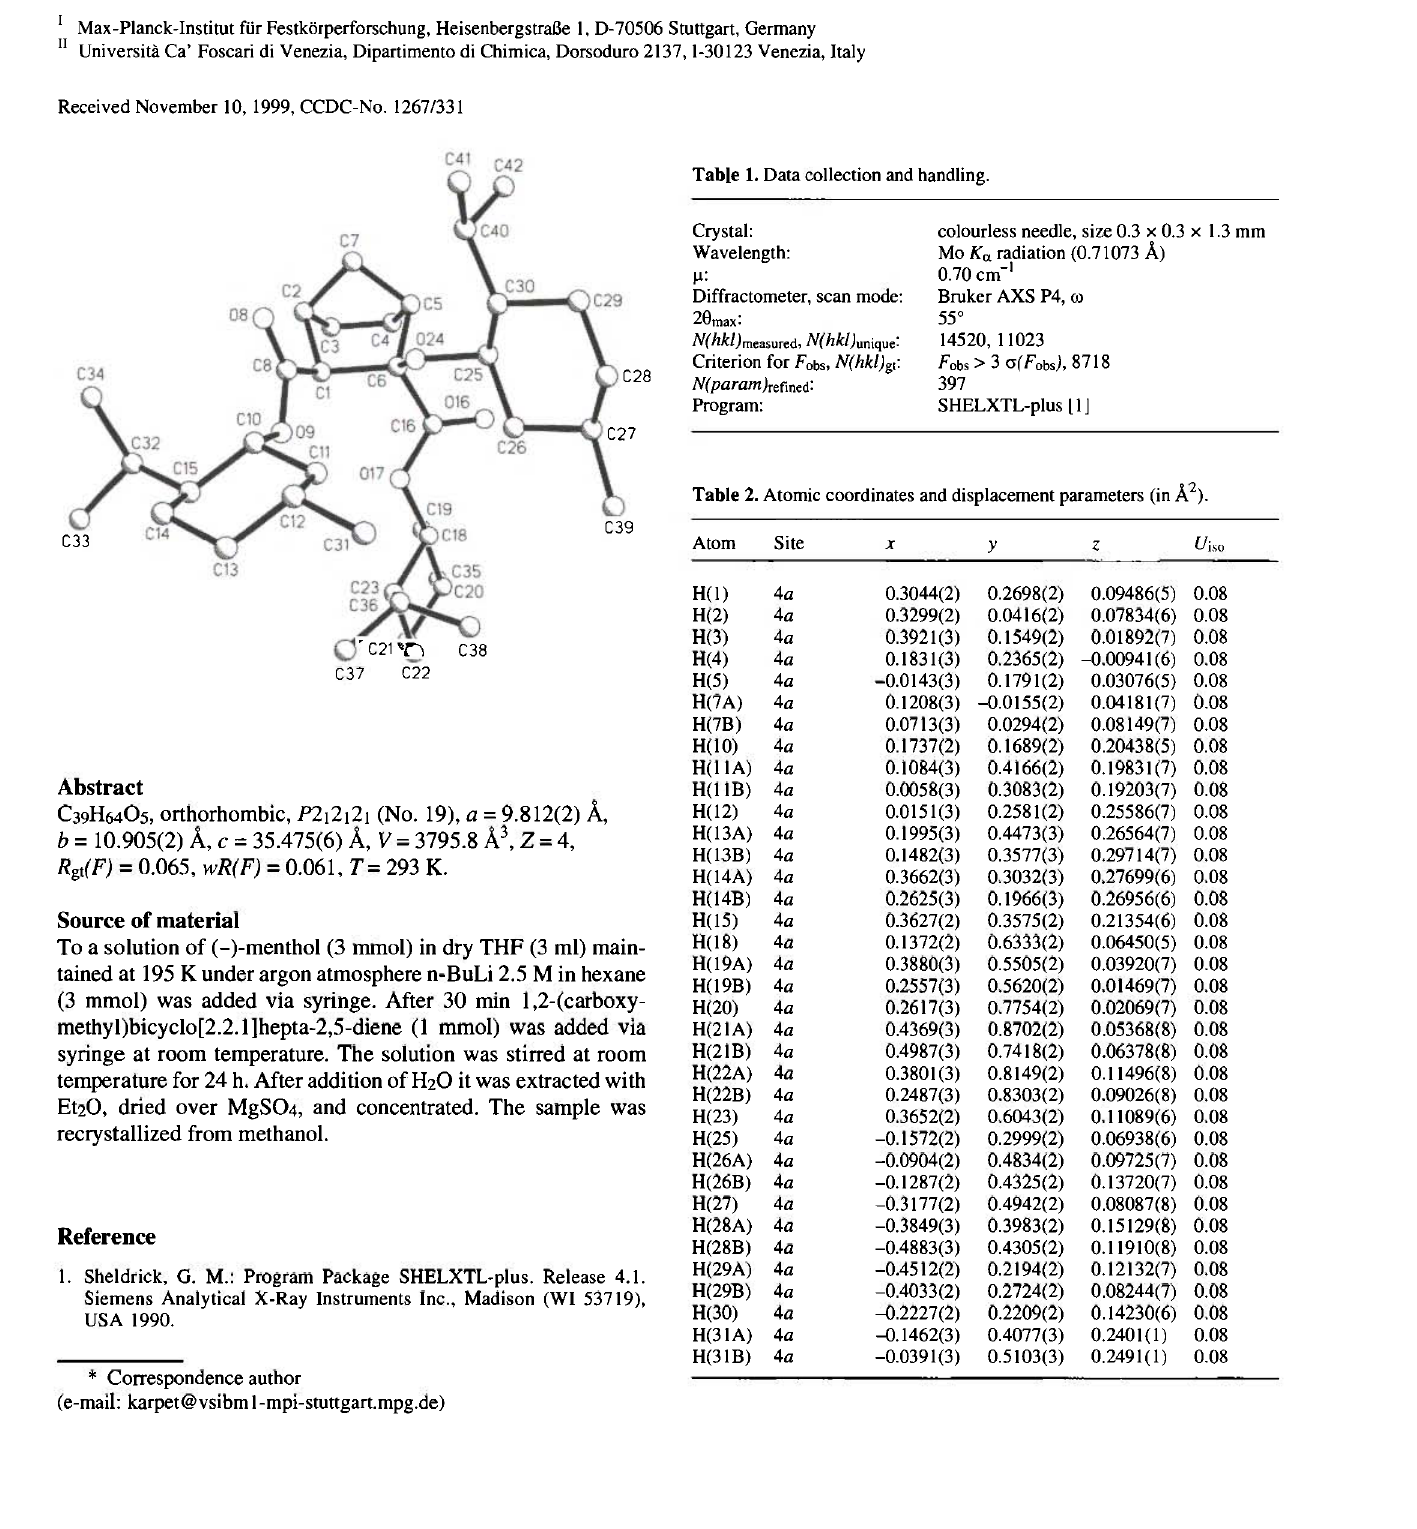
Table 1. Data collection and handling.